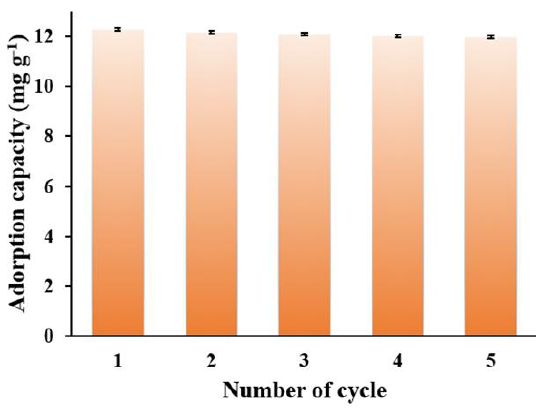
Figure 11. Regeneration property of the MNPC adsorbents in the 10 mg L −1 norfloxacin (NOR) aqueous solution with a dosage of 0.8 g L −1 at a pH of 7.